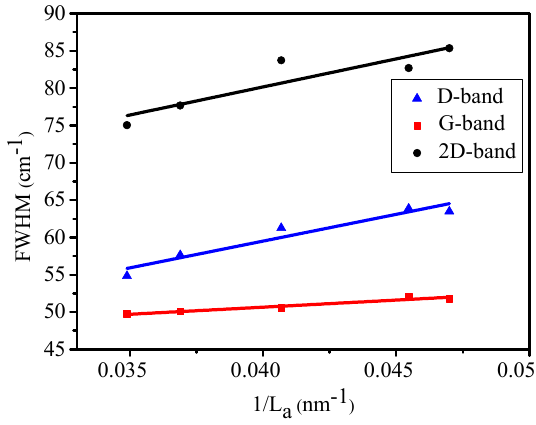
Figure 3. Peak widths of D, G and 2D bands as a function of 1/L a .